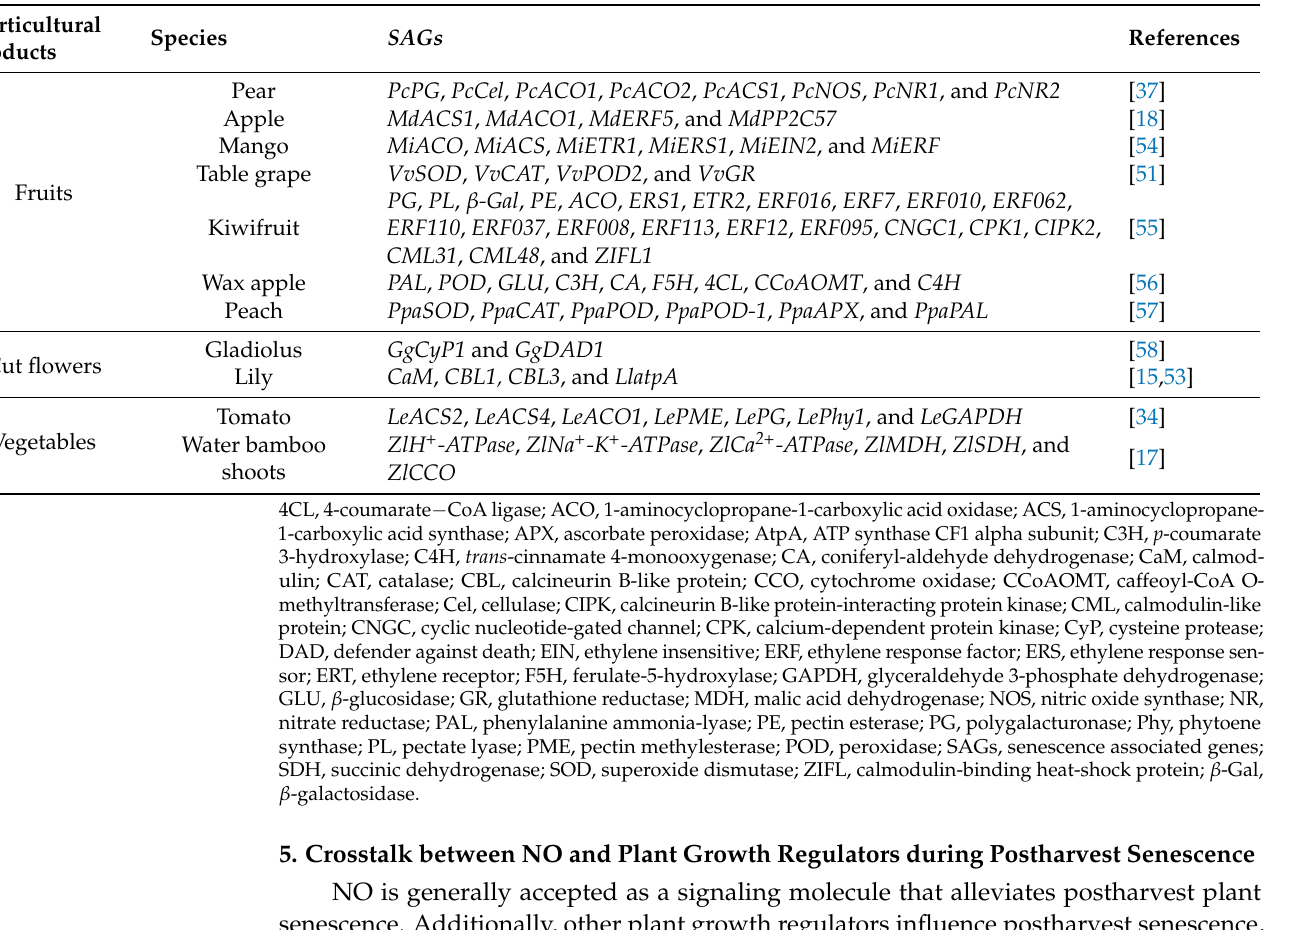
Table 2. NO-regulated SAGs during postharvest senescence